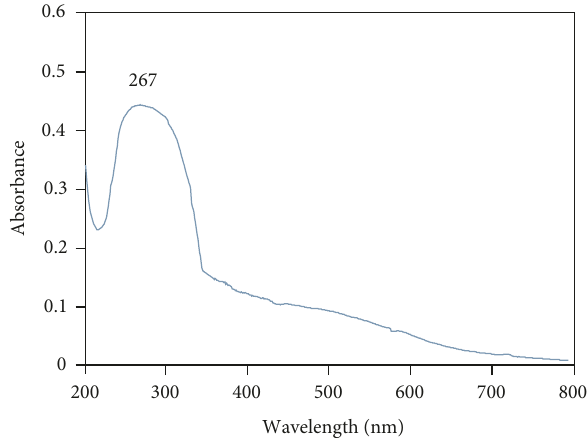
Figure 6: UV-Vis spectroscopy analysis of selenium nanoparticles.